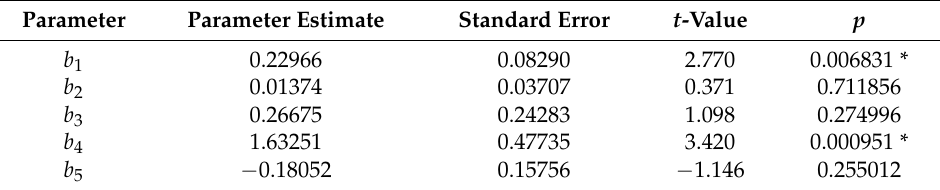
Table 3. Results of the OLS regression of a CDOM 355 algorithm (3) on the test data set. Parameter Parameter